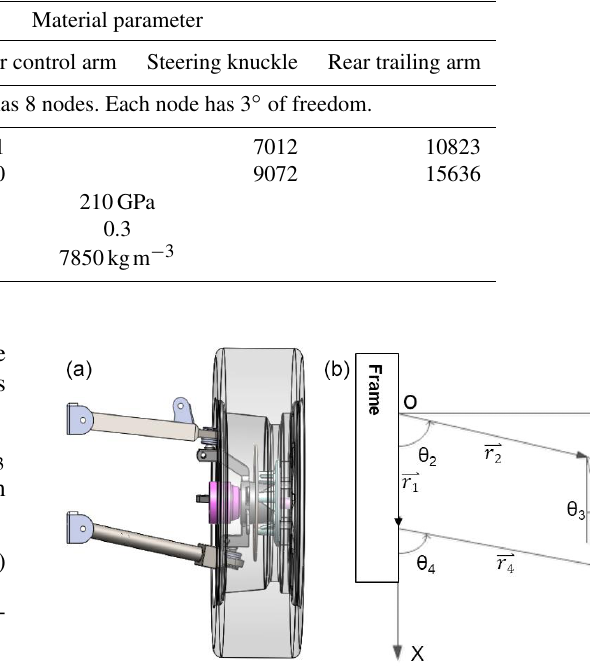
Figure 7. 1 / 4 vehicle CAD model (a) and corresponding vector loop diagram (b)